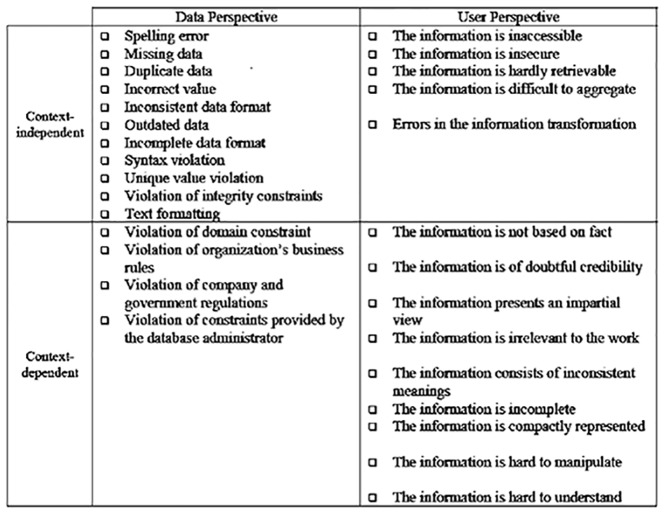
DQ Problem Classification [6].